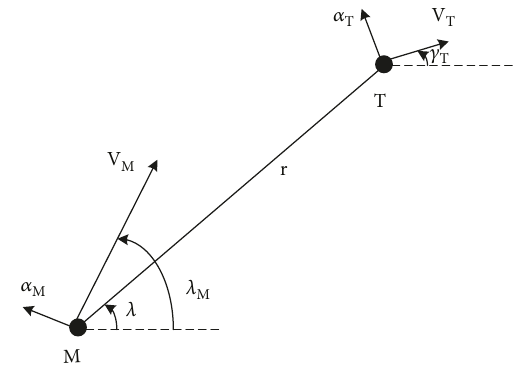
Figure 1: The planar model of the relationship between the missile and the